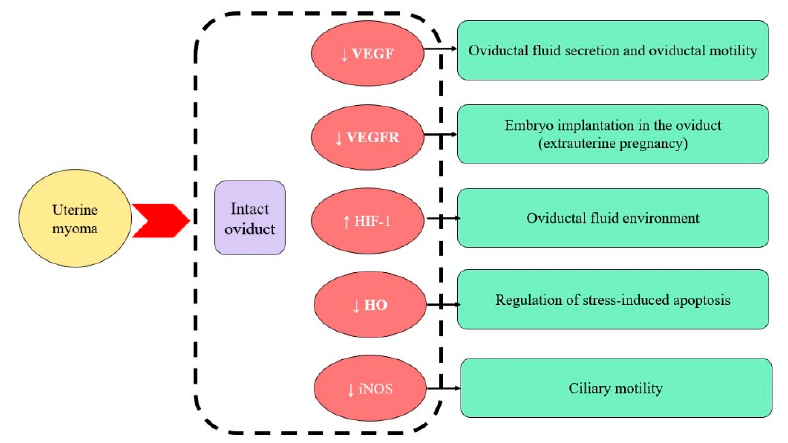
Figure 8. Diversity in oviductal oxygen homeostasis, caused by uterine myoma presence and its consequences in the context of fertility.